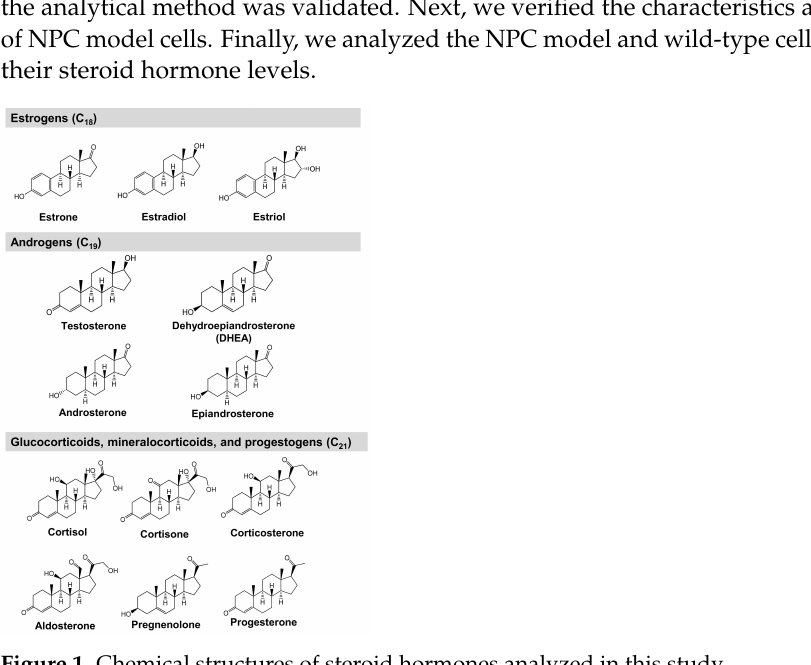
Figure 1. Chemical structures of steroid hormones analyzed in this